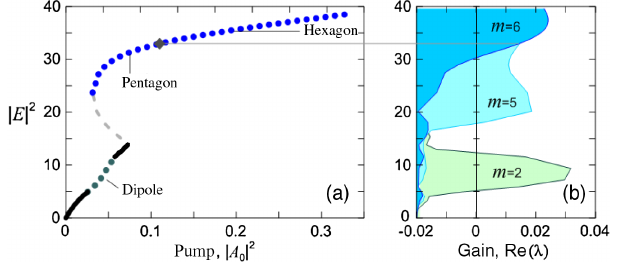
FIG. 6. Pump power dependence and linear stability analysis. (a) Maximum intensity of radially symmetric steady state against pump power. The pump beam has a Gaussian profile with radius R ¼ 18 μ m and phase curvature η ¼ − 0 . 02 μ m − 2 . Stable states are depicted by solid lines whereas dotted lines show unstable solutions spontaneously breaking their radial symmetry. The dashed line represents solutions that are unstable against m ¼ 0 perturbations. (b) Growth rates of leading unstable modes (with angular numbers m ¼ 2 , 5, 6) against intensity of the radially symmetric solution. Other parameters are δ ¼ − 2 . 561 meV, ω ¼ − 3 . 3 meV, γ ¼ 0 . 02 meV, Ω ¼ 2 . 142 meV. These p R parameters are very close to the experimental conditions of Fig. 2.